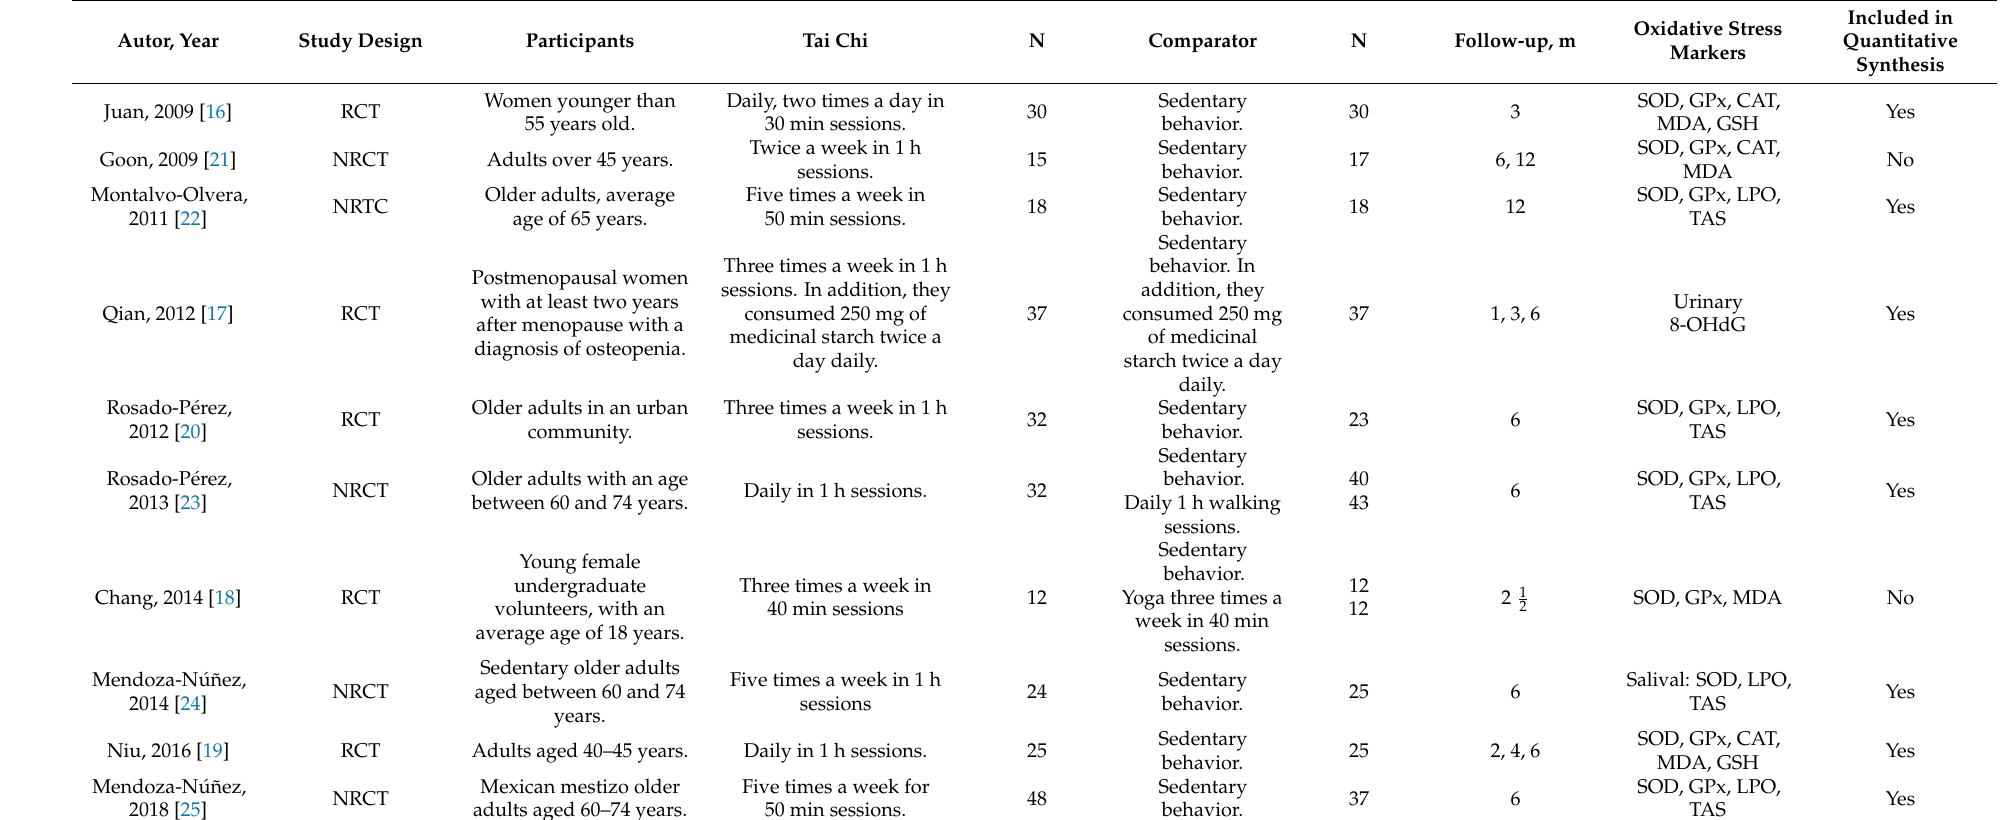
Table 1. Characteristics of the included studies (n =